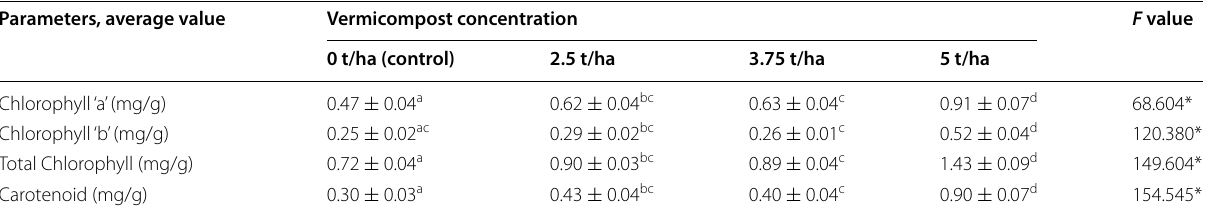
Table 2 Chlorophyll and carotenoid content of ladies finger plants grown in soil fortified with different concentrations of parthenium